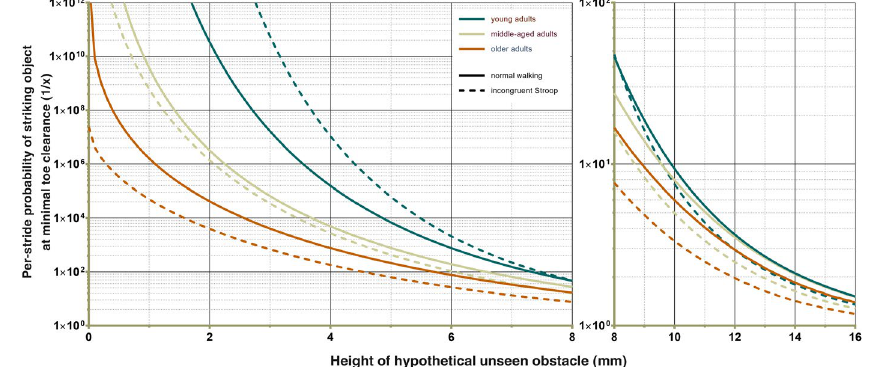
Figure 6. Tripping probability modelling for healthy adults aged 20–80 years during normal walking and under increased cognitive load. Modelling was based on the group frequency distributions and followed the approach taken by Best and Begg 8 . Briefly, per-stride probabilities of striking a hypothetical, unseen obstacle of a given height at MTC are modelled based on MTC frequency distributions, including skewness and kurtosis. Similar graphics for all conditions and age groups may be found in the Supplementary